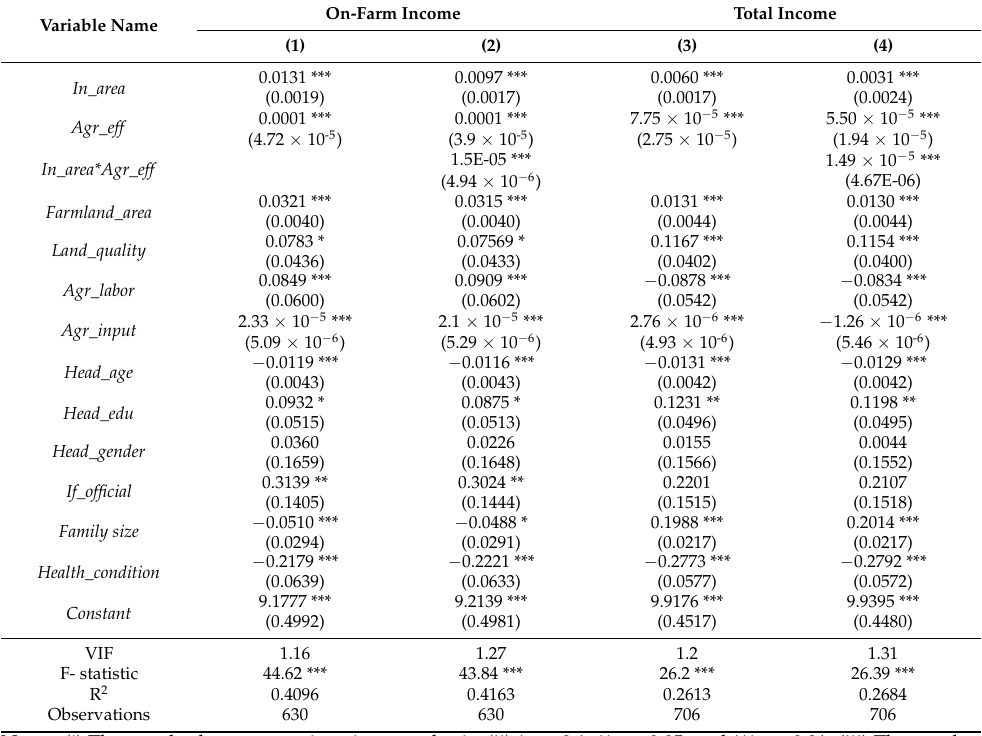
Table 6. The effects of the rented in area and agricultural productivity on household on-farm income for lessee